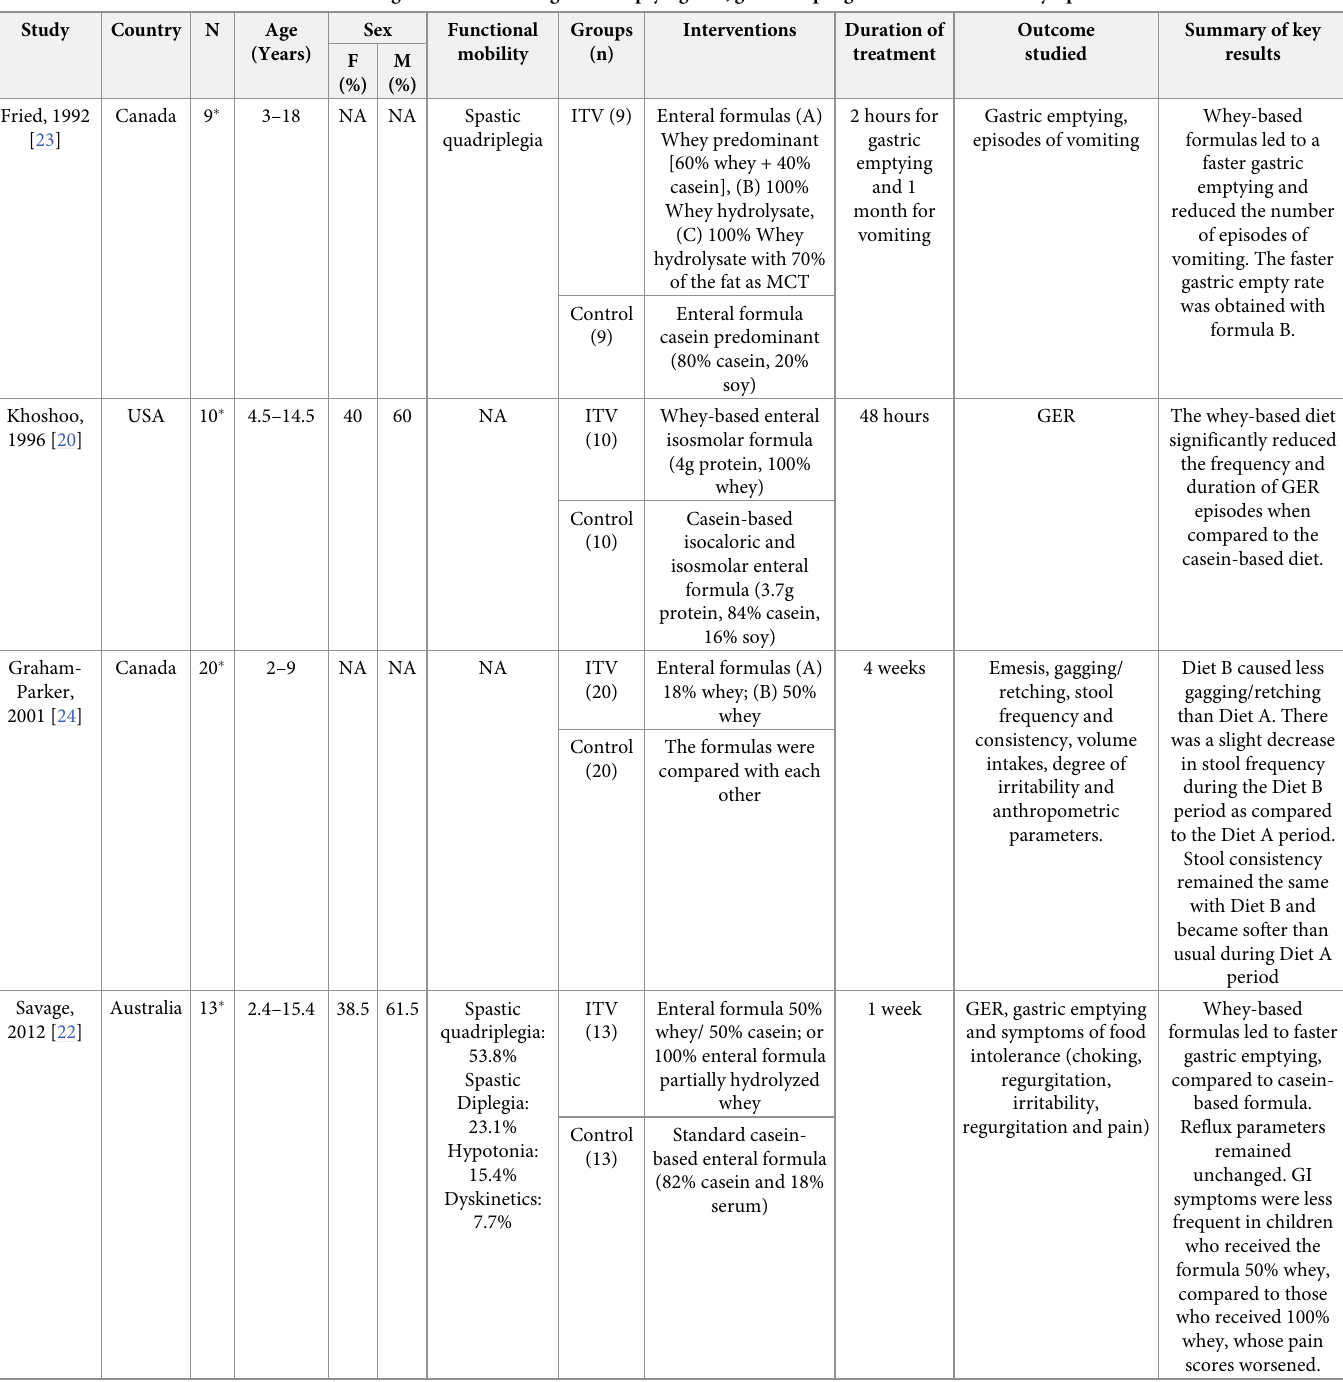
Table 1. Characteristics of the studies evaluating as main outcome gastric emptying rate, gastroesophageal reflux and related